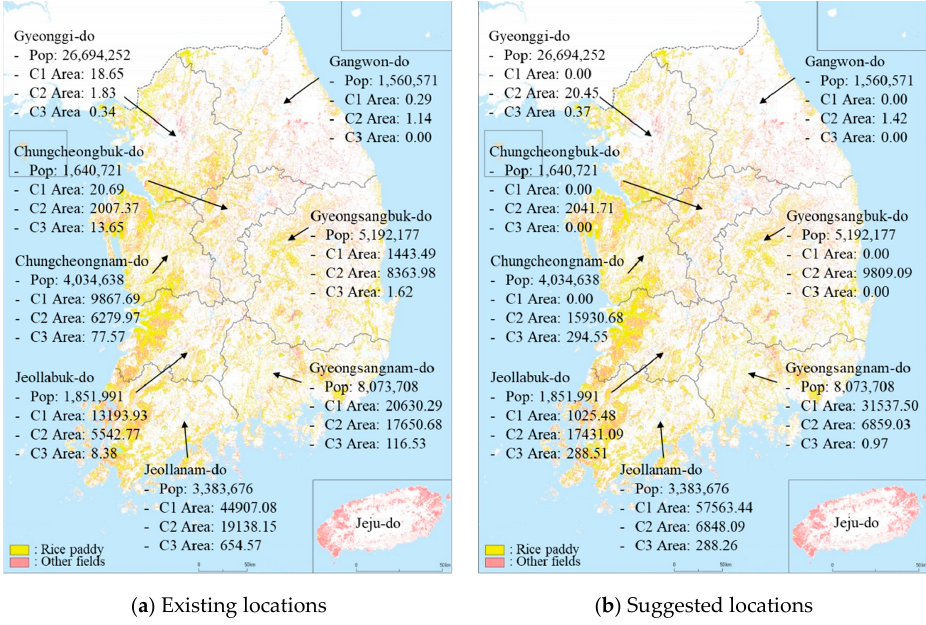
Figure 5. Location–allocation of rice paddy fields (Pop: population, C1 area: harvested area of group 1 in ha, C2 area: harvested area of group 1 in ha, and C3 area: harvested area of group 1 in ha).